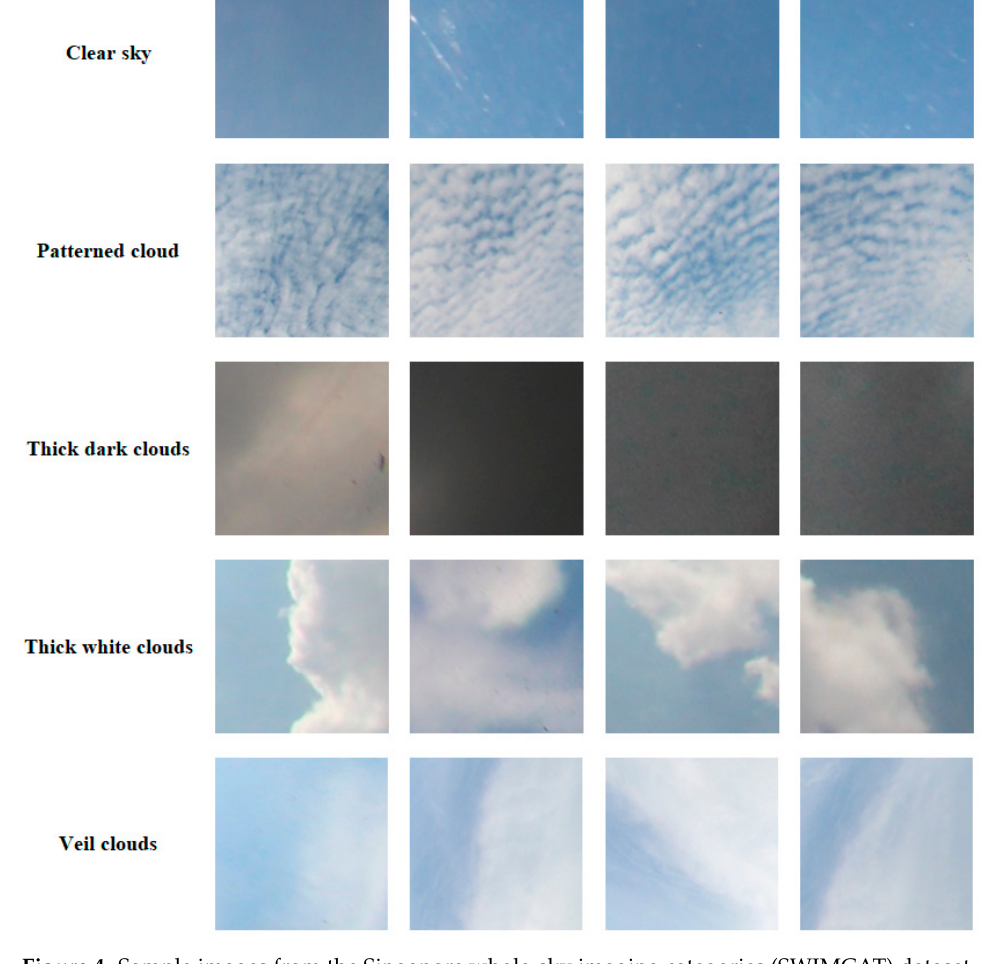
Figure 4. Sample images from the Singapore whole-sky imaging categories (SWIMCAT) dataset. Table 3. SWIMCAT dataset.